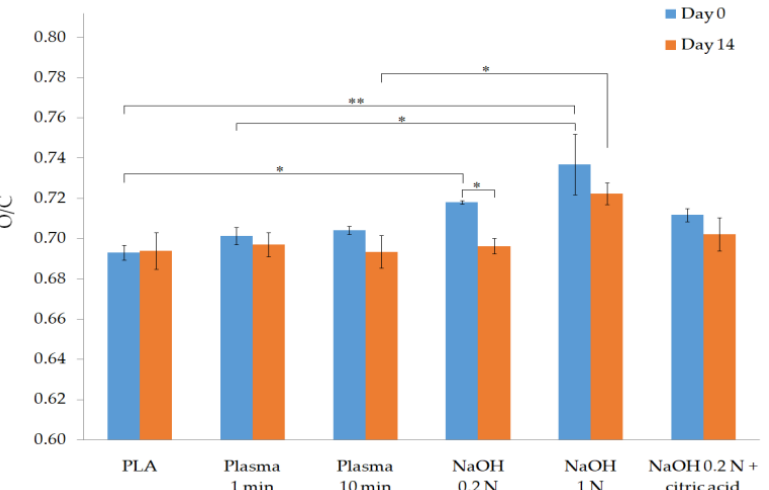
Figure 2. Physicochemical characterization of surface-treated samples by EDX analysis. * p < 0.05 and ** p < 0.01.